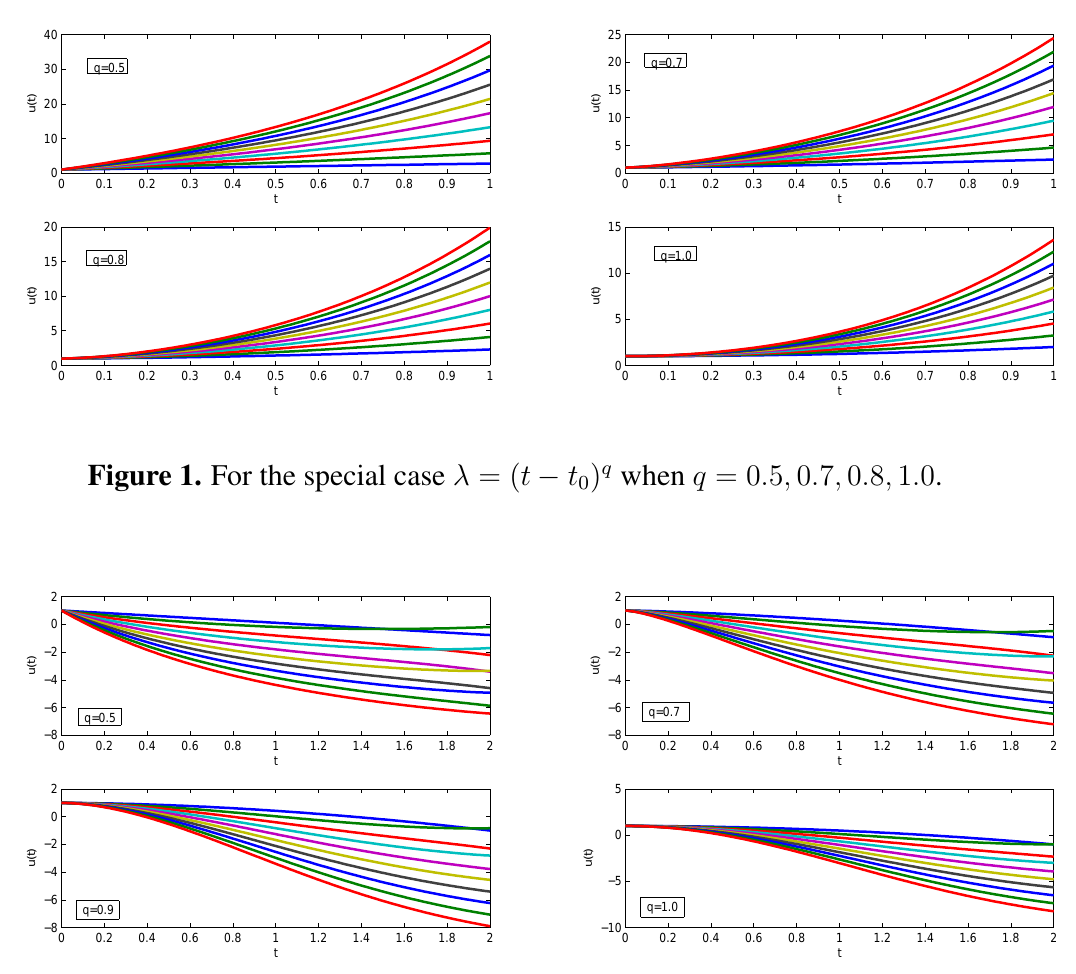
Figure 2. For the special case λ = − ( t − t